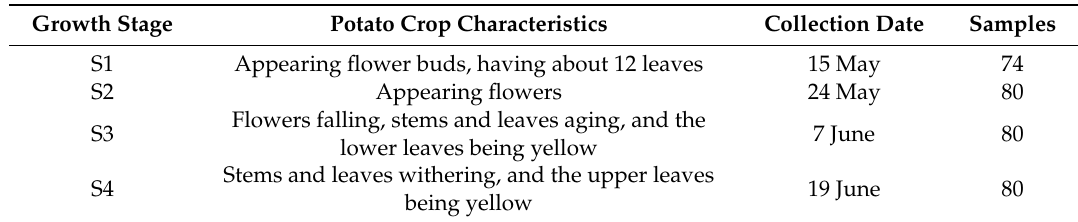
Figure 1. Flow chart of data analysis. Table 1. The information about potato crop samples.